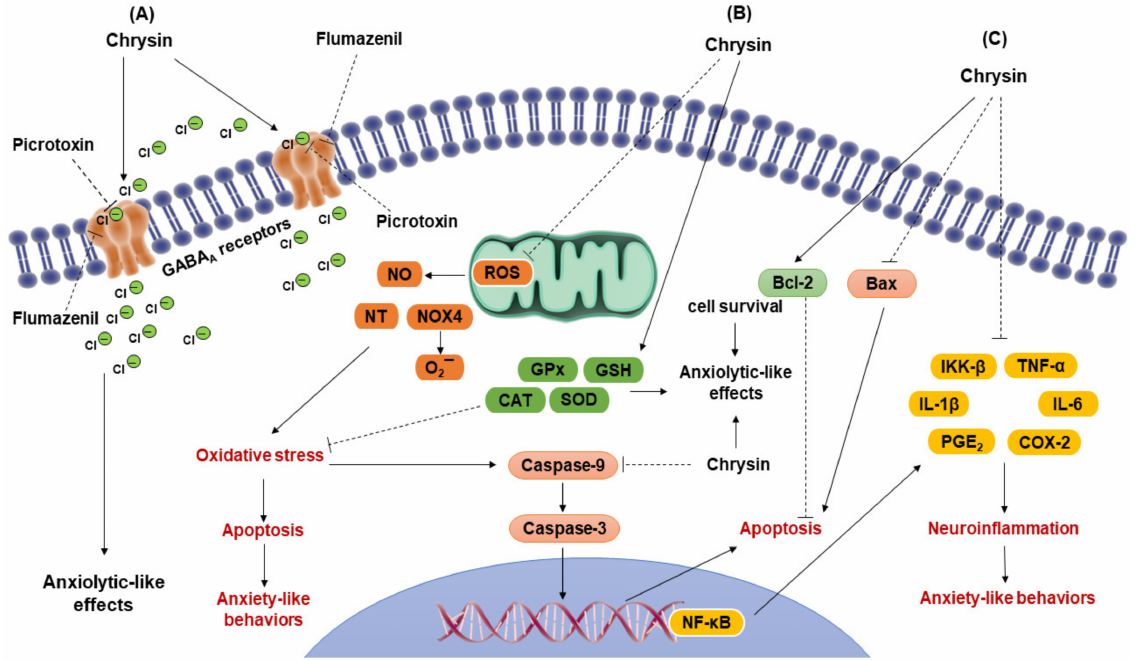
Figure 2. Mechanism of action of the flavonoid chrysin potentially involved in its anxiolytic-like effects. ( A ) It has been confirmed that chrysin produces its anxiolytic-like effect through its